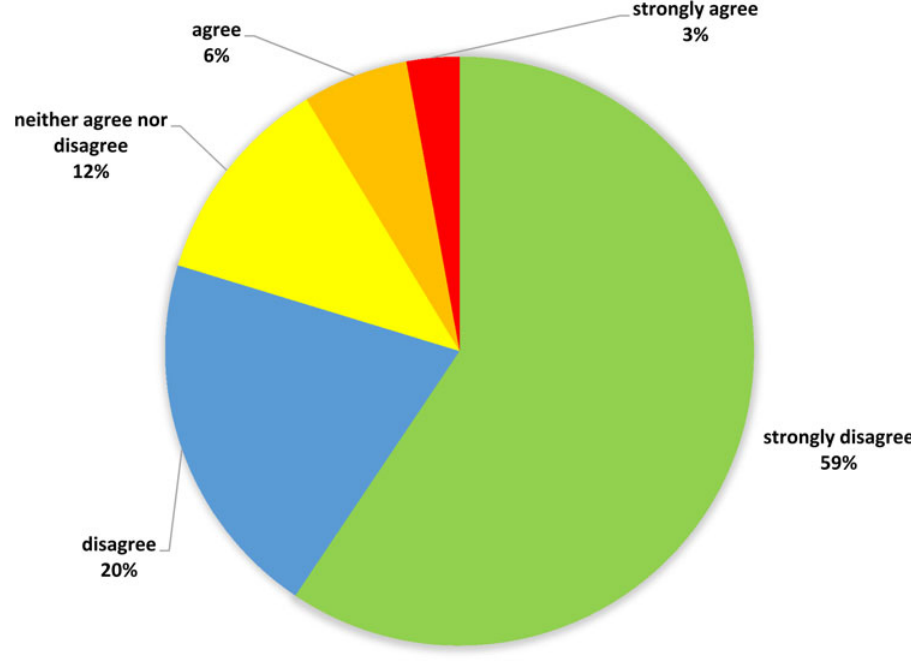
Fig. 1. Likelihood of withdrawing from studies (Q: I ’ m extremely likely to withdraw from my studies).